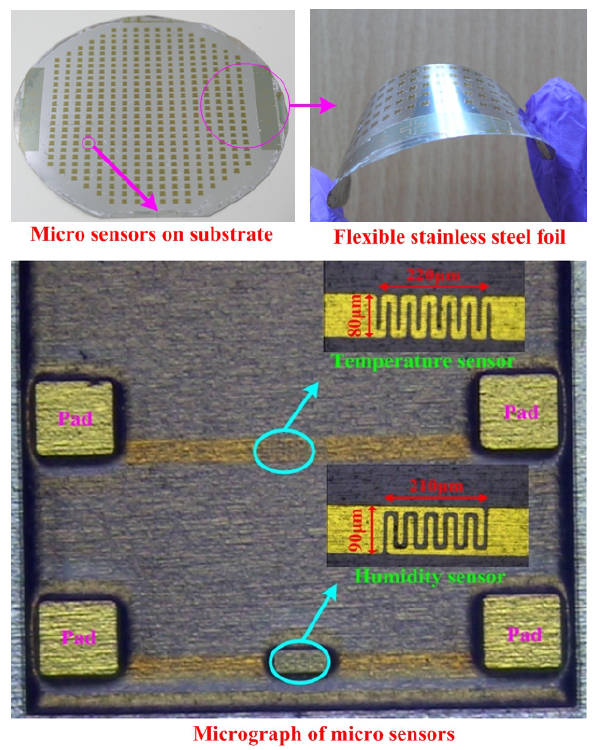
Figure 4. Final flexible micro